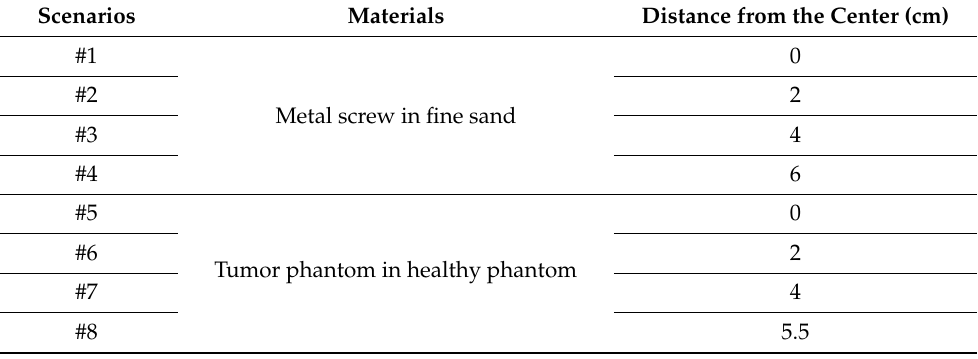
Table 5. Scenarios used in the measurement.